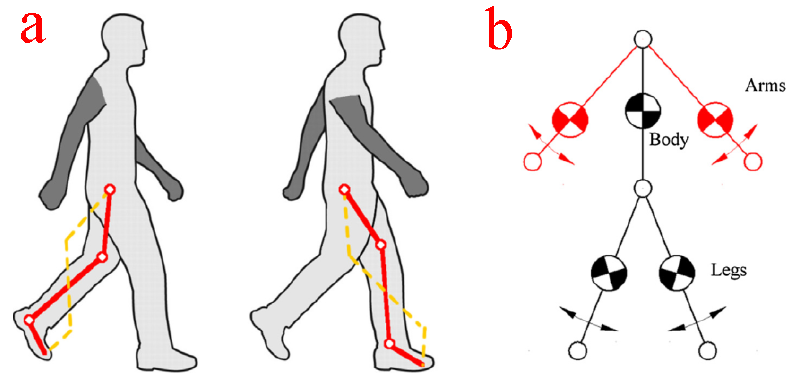
Figure 15. Motion ( a ) and simplified model ( b ) of hand and leg when walking [69].